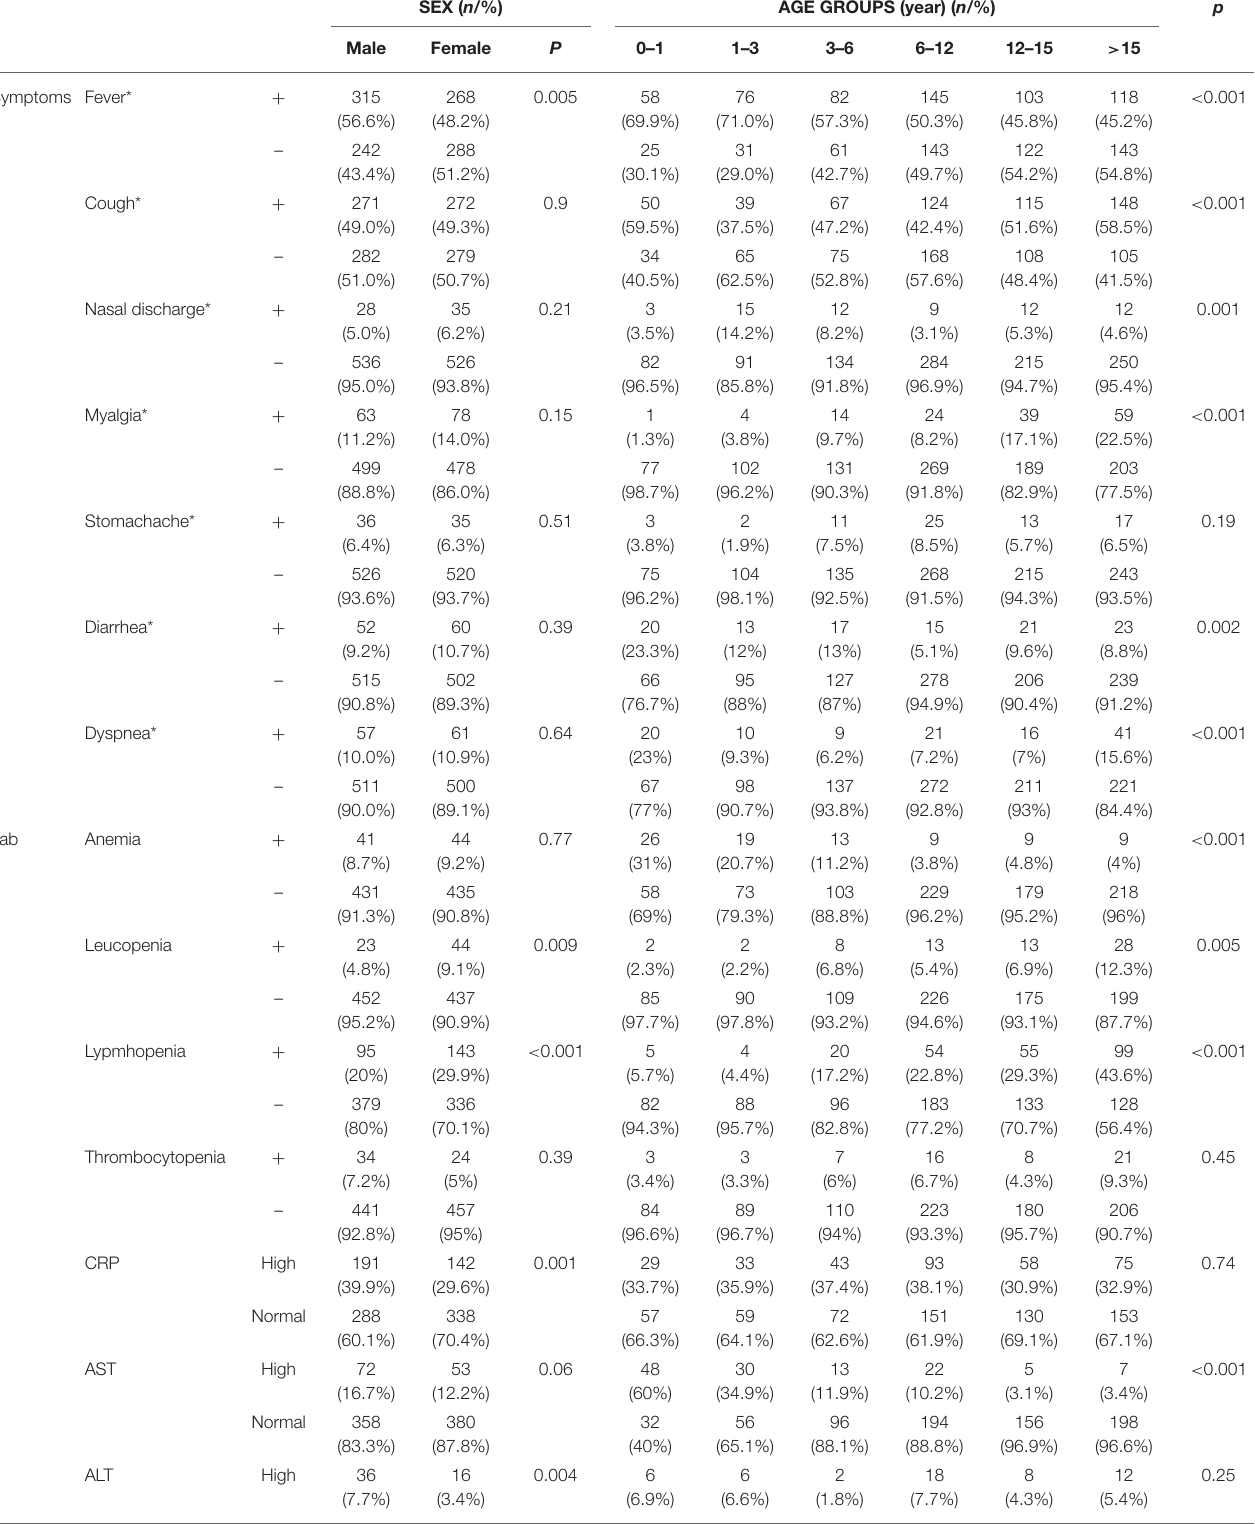
TABLE 3 | Comparison of symptoms and laboratory parameters by means of sex and age groups among total